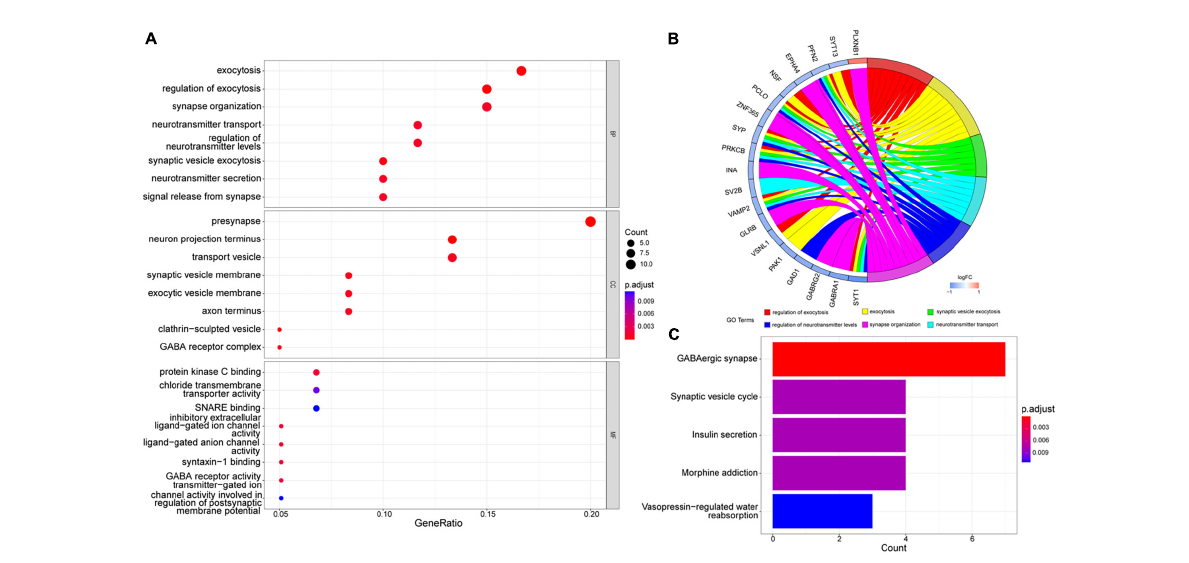
FIGURE3 GO and KEGG enrichment analysis. (A) The most significant enrichment pathways in the GO database. (B) Chord diagram of GO enrichment analysis. (C) The most considerable enrichment pathways in the KEGG database.